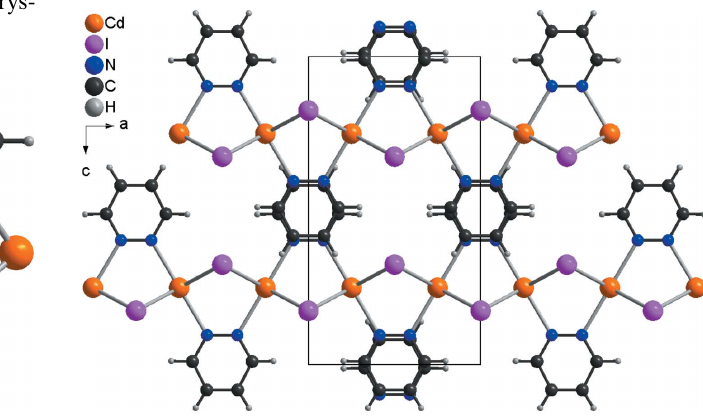
Figure 3 Arrangement of the chains in the crystal structure of 1 in a view along the crystallographic b -axis direction.